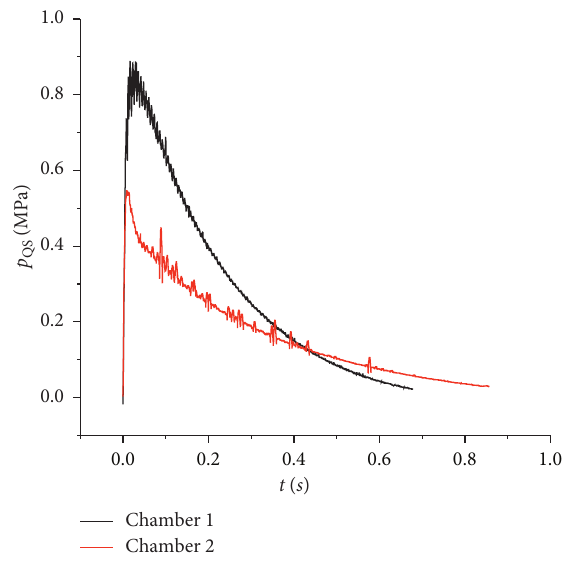
Figure 5: Quasistatic pressure p-t curves of simulated chamber 1 and simulated chamber 2.